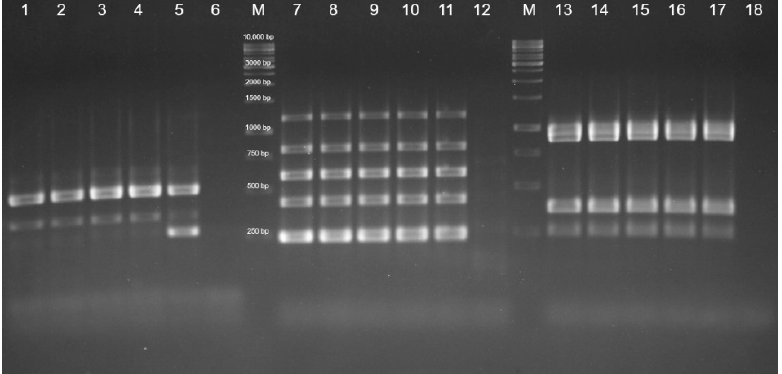
Figure 6. Detection of virulence genes of P. multocida by PCR. Protocol A: detection of SodA (361bp),